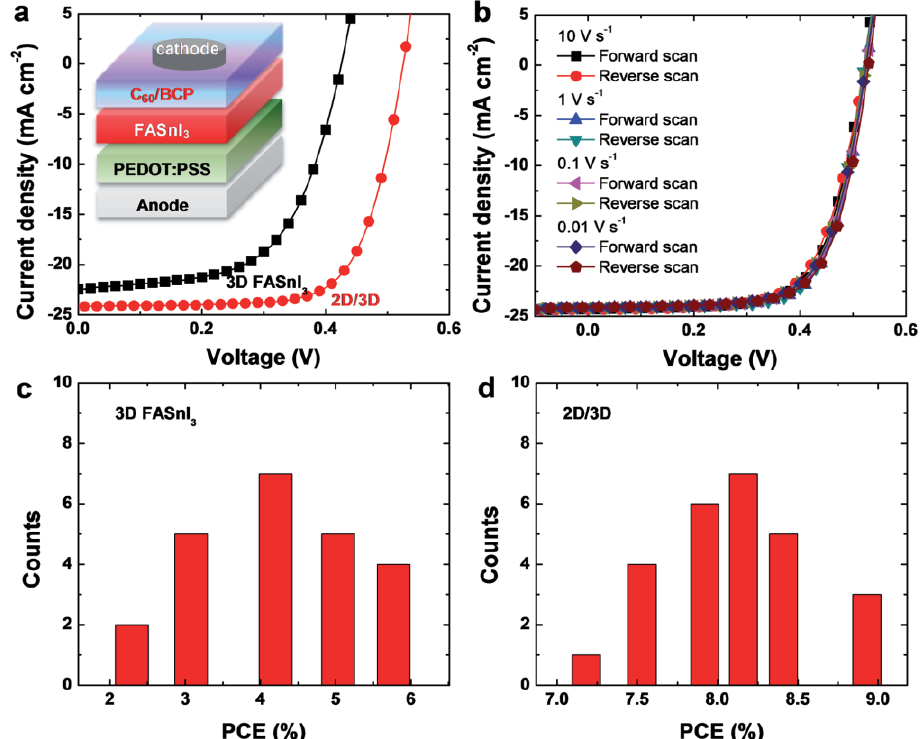
Figure 5. Device structure and characterization. ( a ) J-V curves under one sun AM 1.5 G condition for the champion devices containing pure 3D and 2D (0.008 m)/3D perovskite (the inset shows the device structure); ( b ) forward and reverse sweeps of the J-V characteristics of the champion 2D/3D perovskite cell measured at different rates; ( c ) histogram of the reference cell reproducibility, and ( d ) of the 2D/3D perovskite devices. Reproduced with permission [51]. Copyright-WILEY-VCH Verlag, GmbH & Co. KGaA, Weinheim, Germany,